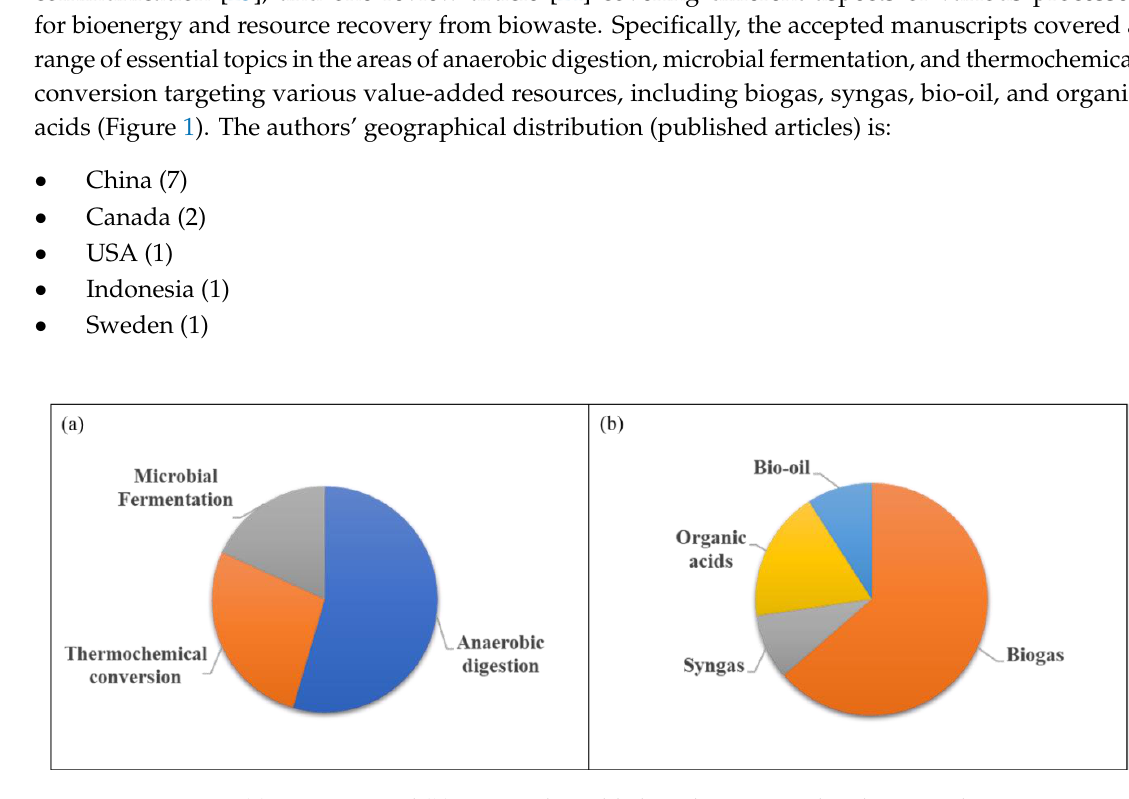
Figure 1. ( a ) Processes, and ( b ) target value-added products covered in this Special Issue.